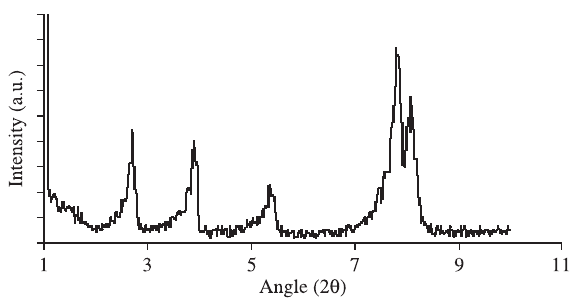
Figure 1. Low angle X-ray diffraction pattern of mesoporous Mn – organo- phosphate molecular sieve.